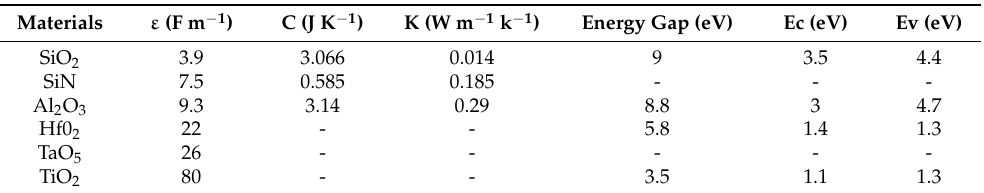
Table 7. Properties of different high-k materials. Reproduced under terms of the CC-BY license [204]. Copyright 2021, Babaya et al., published by Universitas Ahmad Dahlan (UAD). Materials